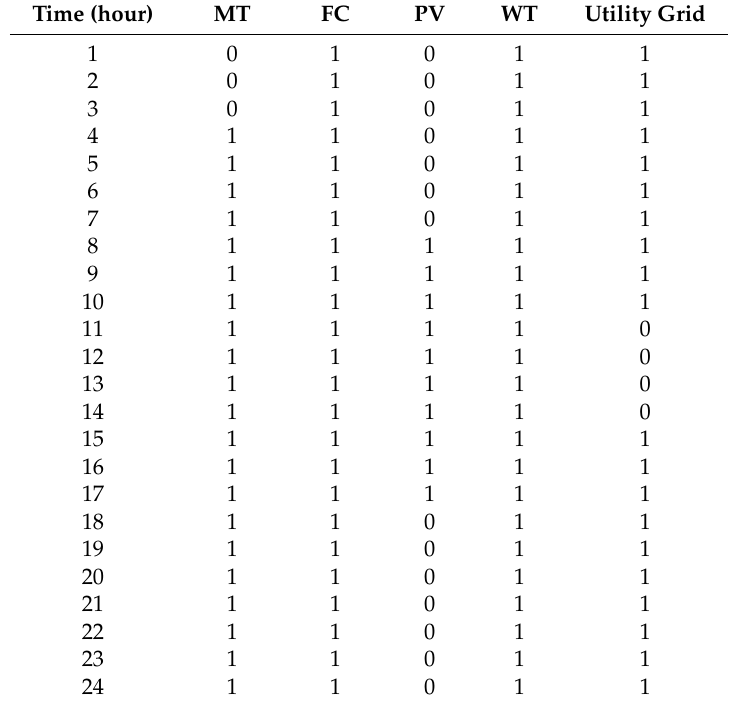
Table 1. Corresponding status of the generation sources obtained by GWO for Scenario A.